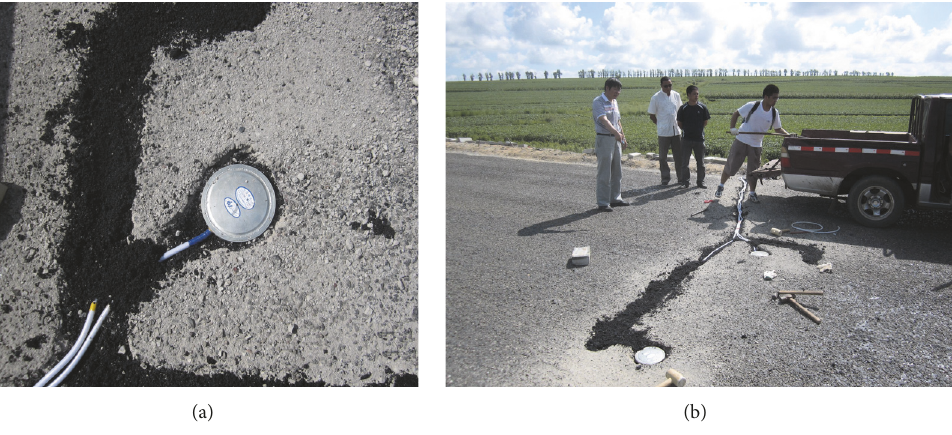
Figure 4: Installation process of the sensor.